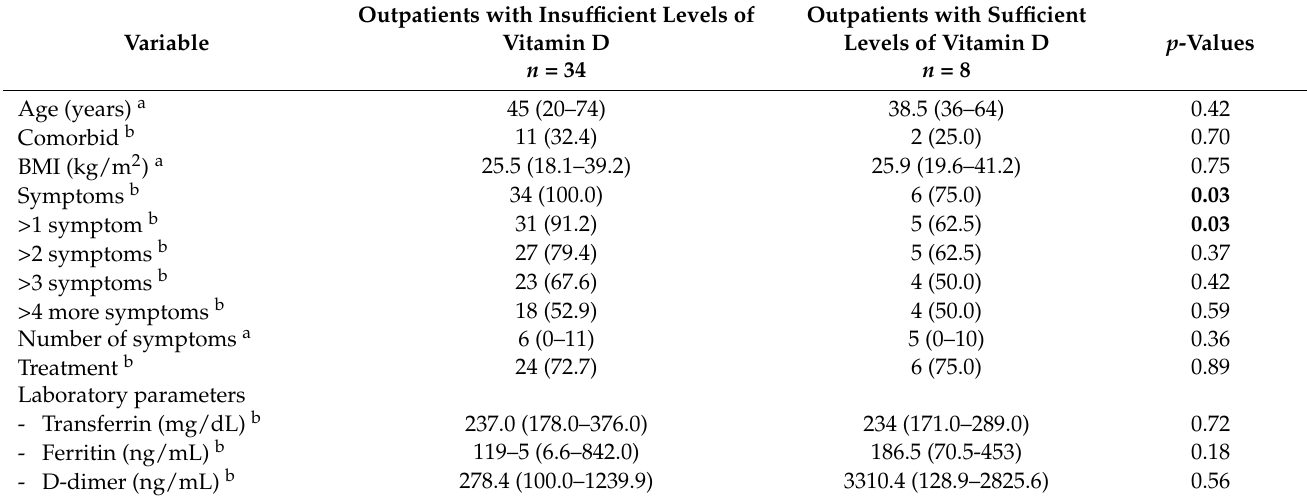
Figure 1. Correlations between clinical and laboratory features of outpatients. Blue colors show negative correlations and orange shows positive correlations (significant correlations are highlighted with a star * p ≤ 0.05 or two stars ** p ≤ 0.01). NEWS = National Early Warning Score, RR = Respiratory Rate, HR = Heart Rate, BMI = Body Mass Index, SpO2 = Oxygen Saturation. Table 2. Comparison between outpatients with sufficient and insufficient levels of total vitamin D at baseline.